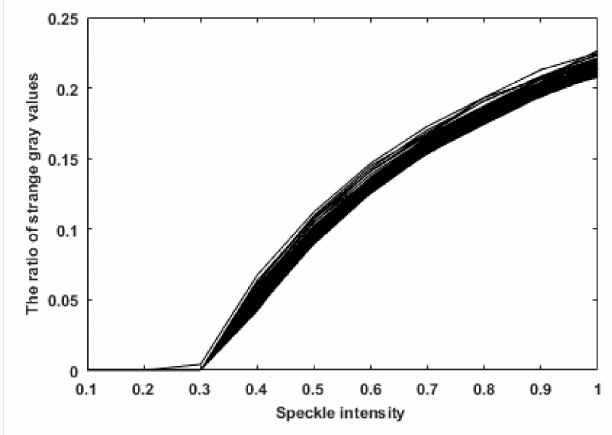
Figure 5. Relationship between the speckle intensity and the proportion of singular